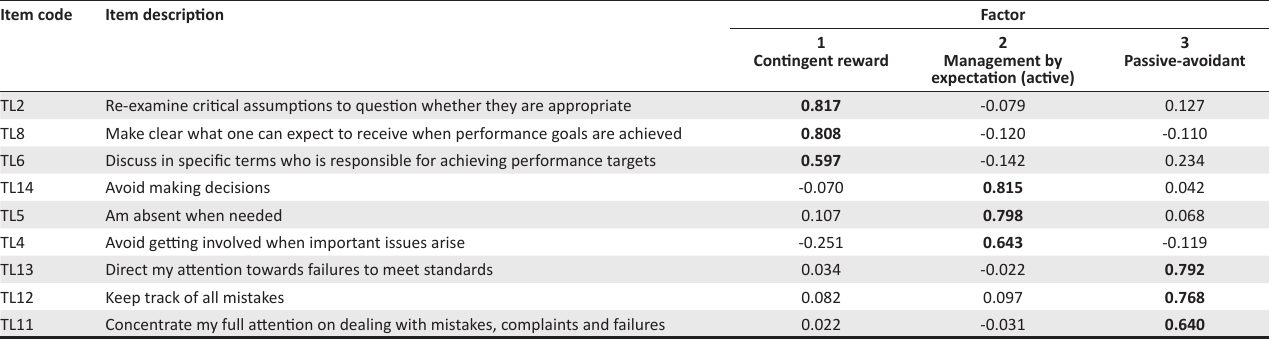
TABLE 3: Three-factor rotated structure for the transactional leadership scale. Item code